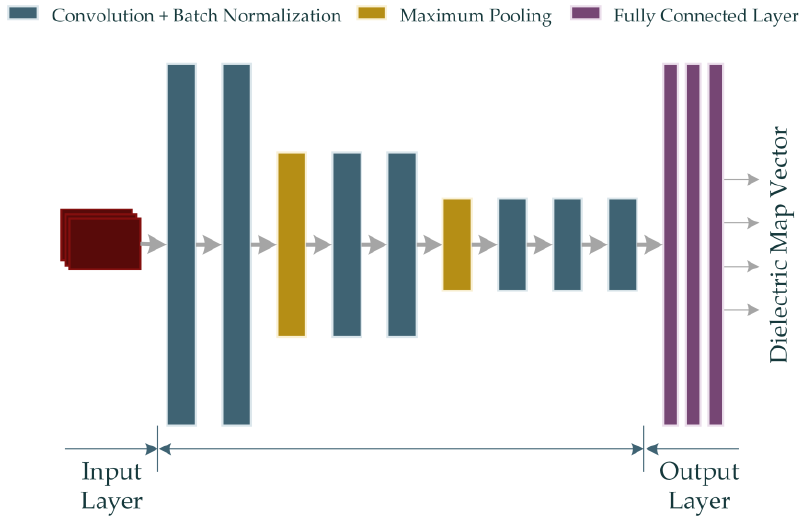
Figure 5. The proposed RV-CNN model for microwave medical imaging (Input data is shown in red red color).